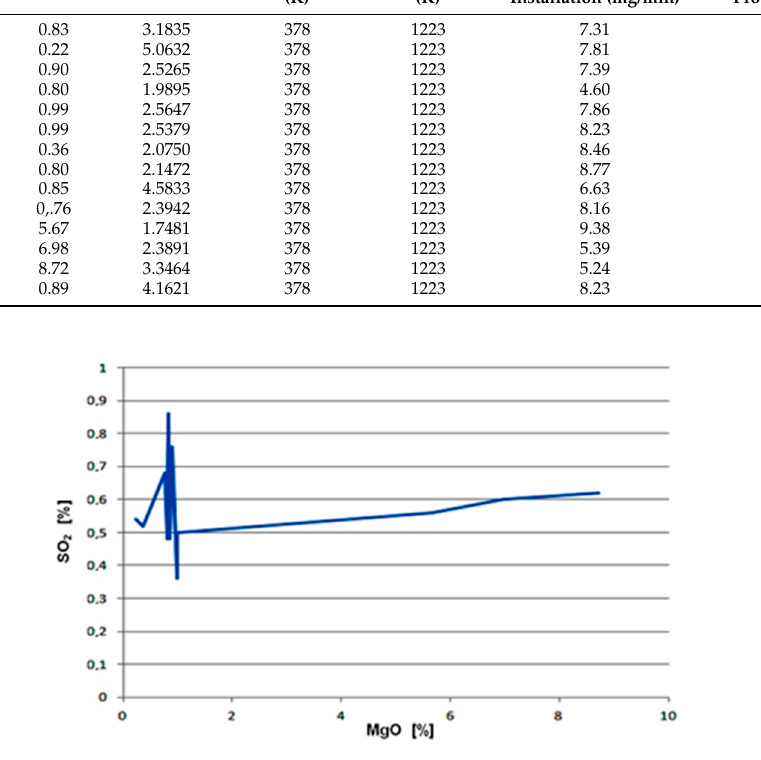
Figure 15. Relation between the amount of sulfur SO 2 (%) of the post-reaction product and the MgO (%) content of carbonate sorbent [21].